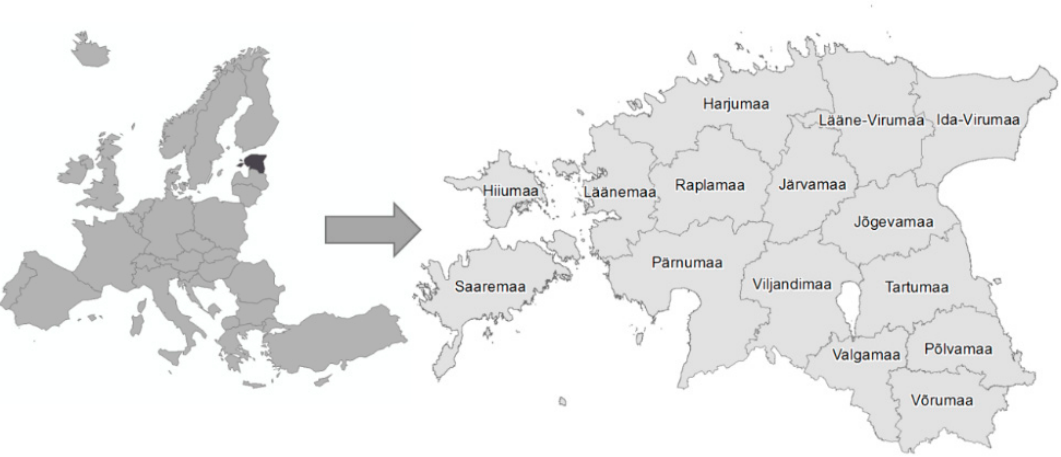
Figure 1. Location of Estonia (study area) in Europe.